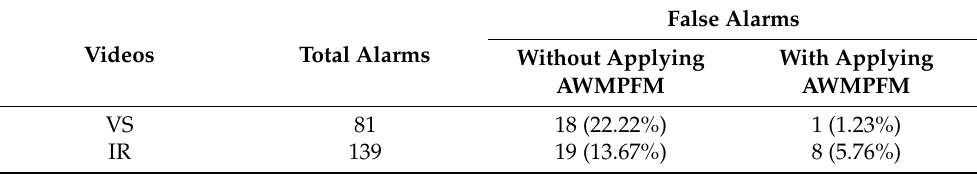
Table 3. Comparison of moving object detection results with and without applying AWMPF.